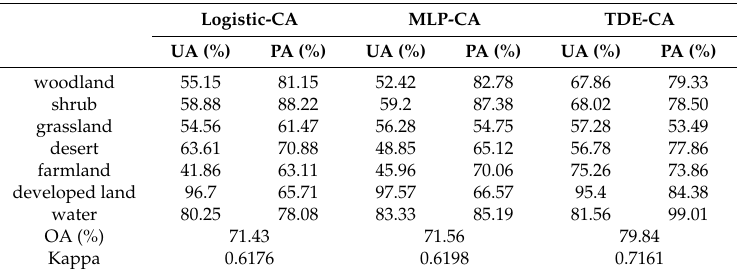
Table 6. Comparison of the TDE-CA and other models in simulation